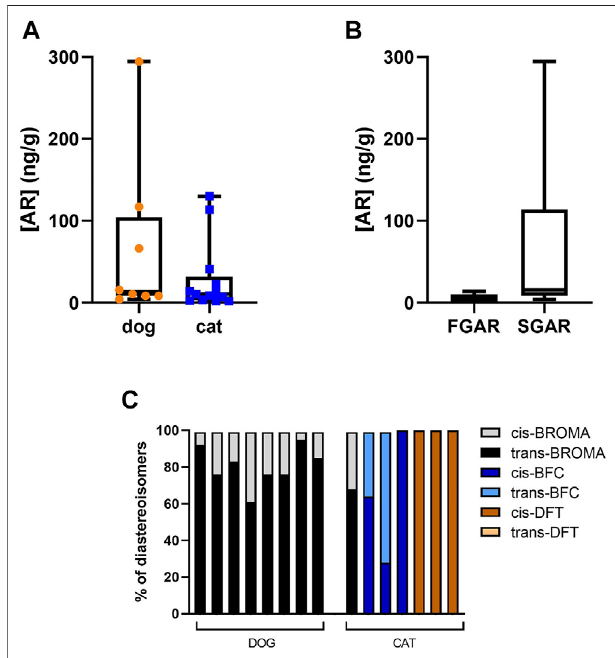
FIGURE 4 | In (A) Concentration of AR in feces of exposed dogs and cats. In (B) FGARs and SGARs concentration in feces of exposed dogs and cats. In (C) cis and trans-isomers proportion in feces of each animal exposed to SGARs among the dog and cat